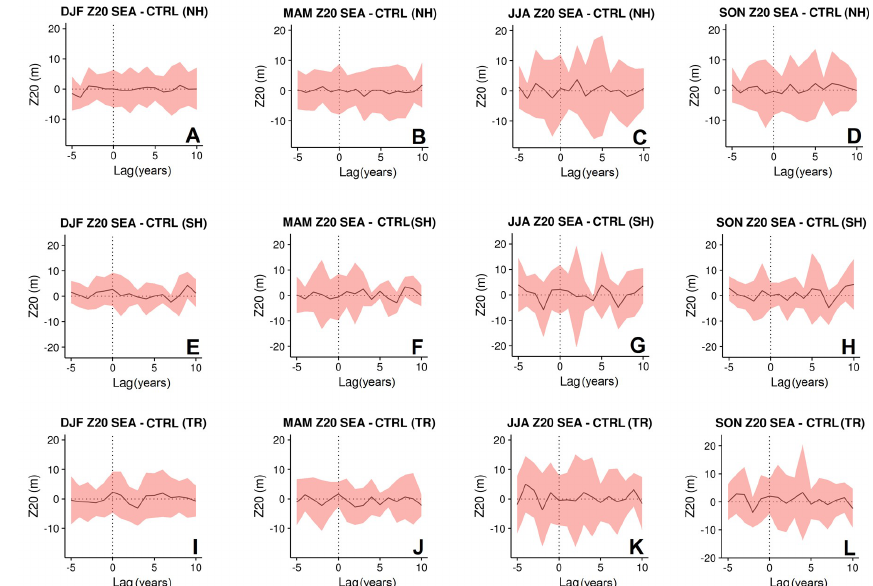
Figure 6. VOLC SEA for thermocline depth seasonal anomalies (m), calculated considering the volcanic eruptions listed in Table 1, for five years before the eruption and ten years after the eruption. Horizontal: class of the eruptions (NH—( A – D ); SH—( E – H ); and TR—( I – L )); Vertical: seasonal SEA (December to February—DJF; March to May—MAM; June to August—JJA; and September to November—SON). Lines in colors correspond to the individual ensemble members, and black thick line refers to the ensemble mean. Light shaded gray corresponds to one standard deviation, and dark shaded gray corresponds to two standard deviations. Magenta solid line corresponds to one standard deviation of the CTRL run.